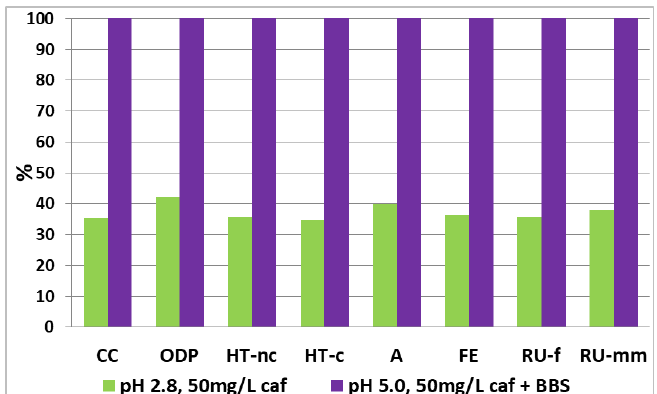
Figure 3. A comparison of the photo Fenton option for the degradation process of 1 m 3 of water per day (caffeine concentration of 50 mg/L). The values are reported grouped for impact category and as a percentage, assigning 100% to the greatest impact for each category analyzed.